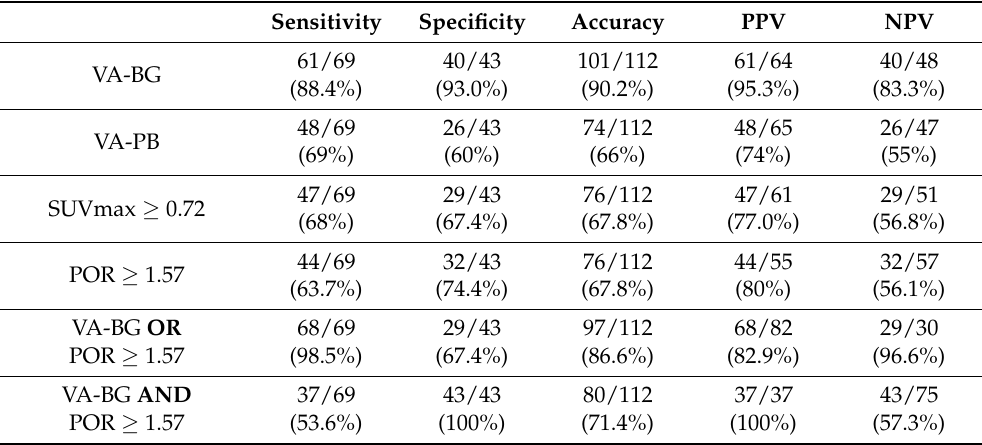
Figure 2. Receiver operating characteristic (ROC) curves for NSD identi fi cation according to pineal body SUVmax (left, AUC = 0.67) and pineal to occipital cortex uptake ratio (POR, right, AUC = 0.71). Table 4. Diagnostic performance parameters provided by pineal body 18 F-DOPA uptake assessment.